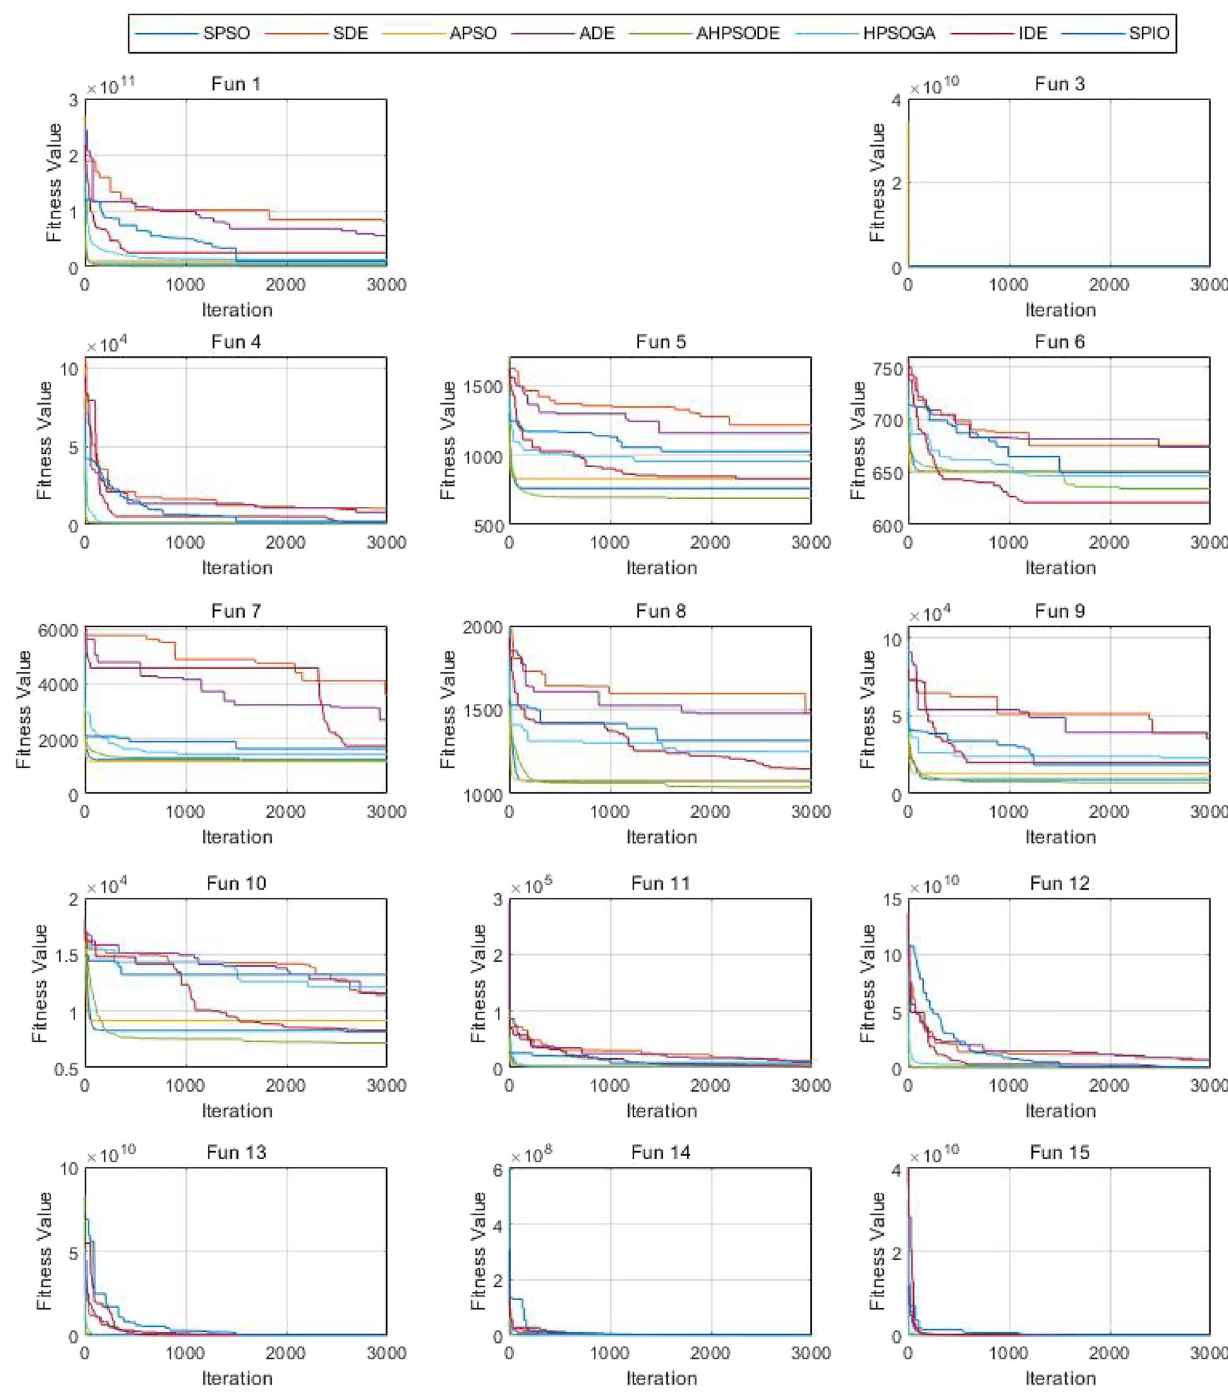
Fig. 25 Convergence curve of different algorithms on CEC 2017 at 50-D (Fun